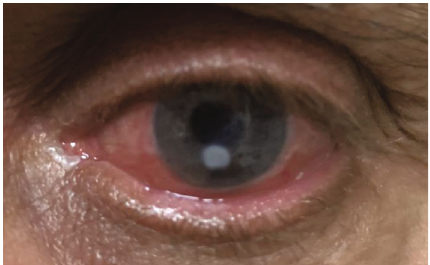
Figure 2: Patient at follow-up with 20/40 vision with persisting but improving in fi ltrate. Partial conjunctival fl ap is rotated